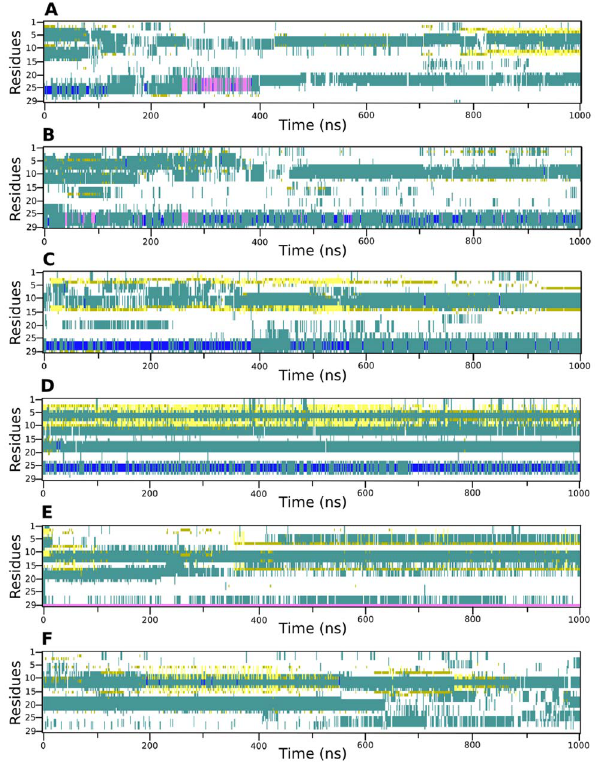
Fig. 4. Secondary structure of the N-terminal region of the Arg and Gly variants of b 2 AR. Panels A, B and C represent simulation number 1, 2 and 3 of the Arg variant and panels D, E and F represent simulation number 1, 2 and 3 of the Gly variant, respectively. Turns are indicated by cyan color, 3–10 helices are indicated by blue, alpha helices are indicated by pink, isolated bridges are indicated by mustard and extended configuration is indicated by yellow color.